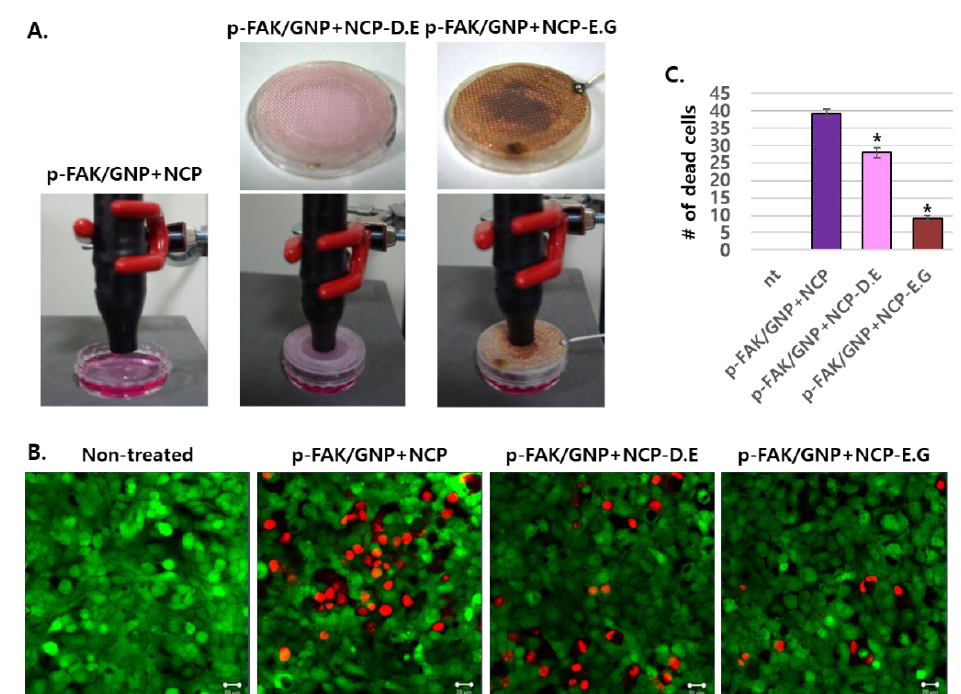
Figure 4. The p-FAK/GNP+NCP-mediated immediate cell death was blocked by electric grounded mesh. ( A ) Photographs showing the NCP treatment methods for p-FAK/GNP+NCP, p- FAK/GNP+NCP-DE (de-electric mesh) and p-FAK/GNP+NCP-EG (electric grounded mesh). ( B ) The results of the live/dead assay after the NCP treatment using 3 different methods. The SCC25 cells were pretreated with p-FAK/GNP for 1 h before the NCP or PAM treatment. The photographs